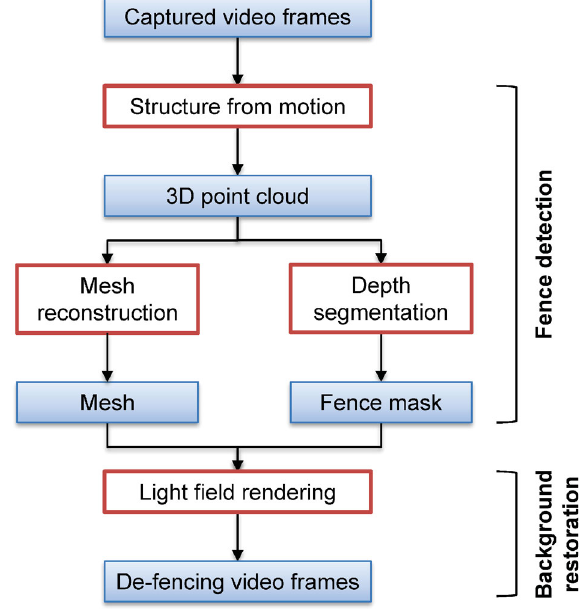
Fig. 1 Overview of proposed method.